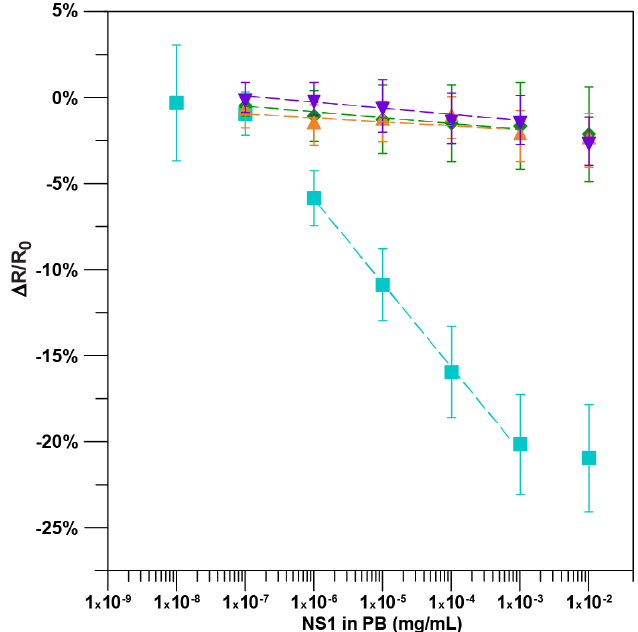
Figure 2. Immunosensor calibration plot: normalized response of the immunosensors functionalized with bovine serum albumin (BSA), Tween-20, anti-NS1 antibody after incubation with NS1 protein in PB [ n = 7; y = −4.88x − 35.23, R 2 = 0.99] ( ■ ), after incubation with PB only [ n = 6, y = −0.36x − 2.4, R 2 = 0.91] ( ▼ ), and after incubation with BSA protein in PB [ n = 9; y = −0.24x − 2.6 R 2 = 0.53] ( ▲ ). Normalized response of the immunosensors functionalized with BSA and Tween-20 but without antibody to the incubation of NS1 protein in PB [ n = 8; y = −0.34x − 2.9, R 2 = 0.93] ( ♦ ). The data points are the mean of measurements from independent immunosensors, and error bars represent ±1 standard deviation.